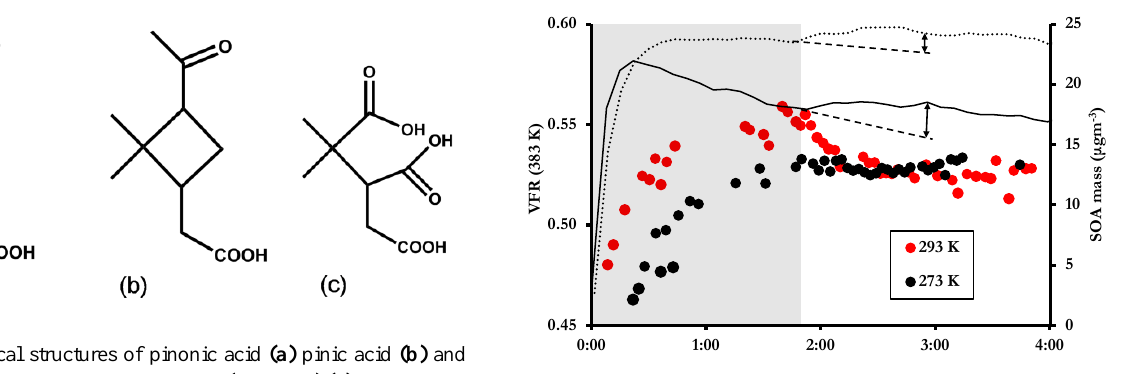
Fig. 8. Chemical structures of pinonic acid (a) pinic acid (b) and 3-methyl-1,2,3-butanetricarboxylic acid (MBTCA) (c) .